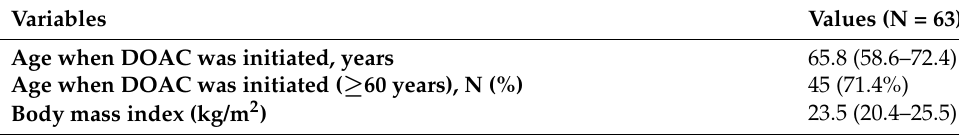
Table 1. Clinical characteristics of the study